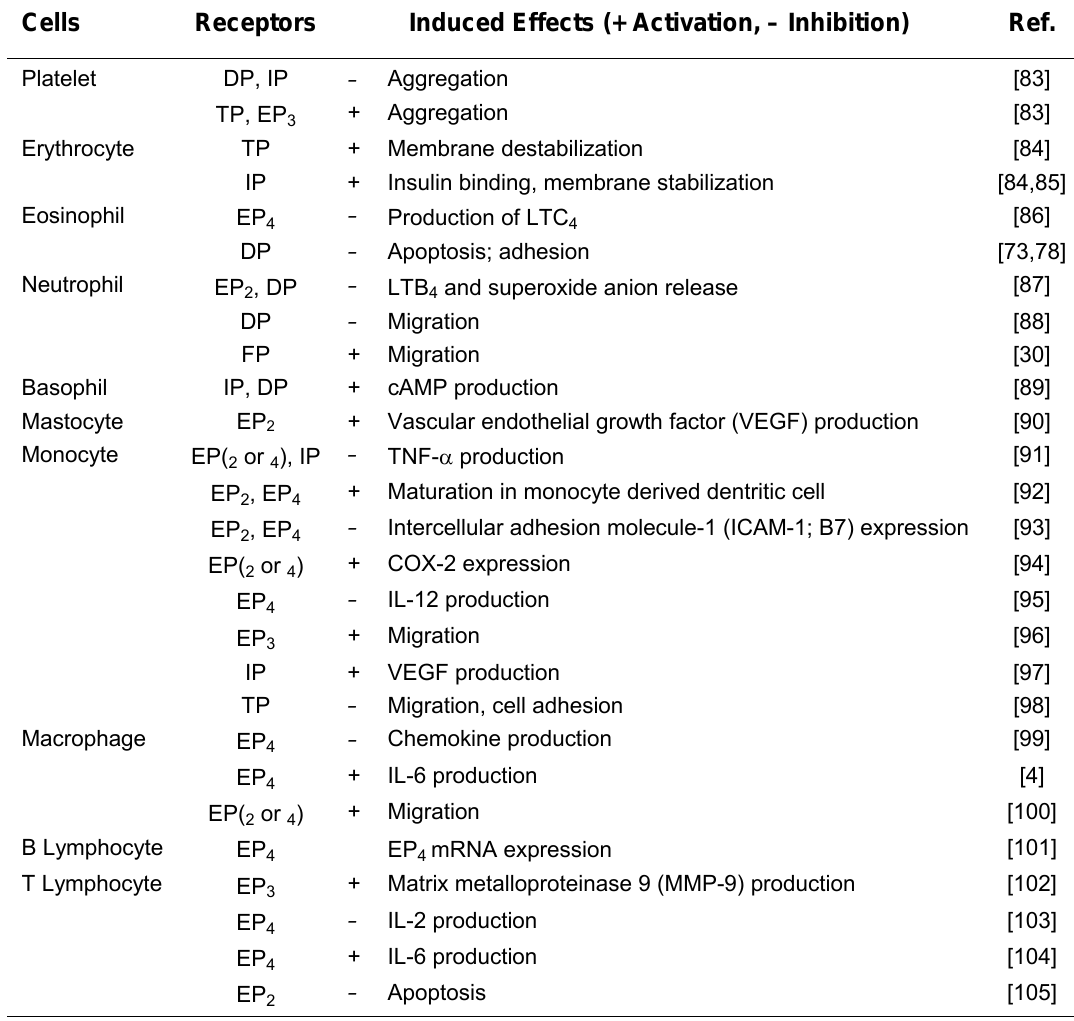
Prostanoid Receptors in Human Blood